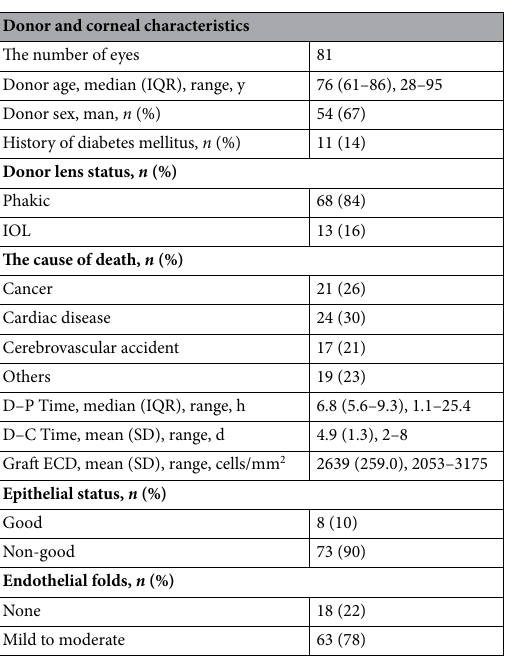
Table 1. Baseline donor and corneal demographics. D–C, death to cutting; D–P, death to preservation; ECD, endothelial cell density; IOL, intraocular lens; IQR, interquartile range; SD, standard